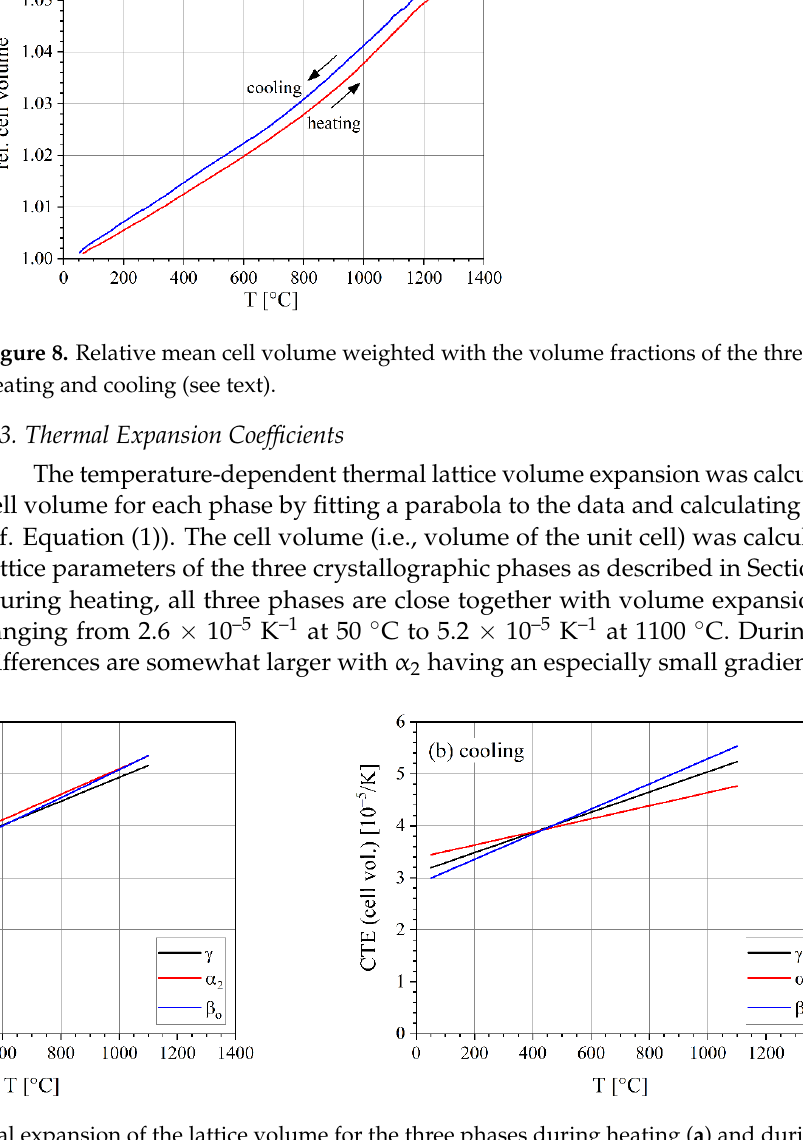
the unit cell volume is slightly larger during the cooling segment.